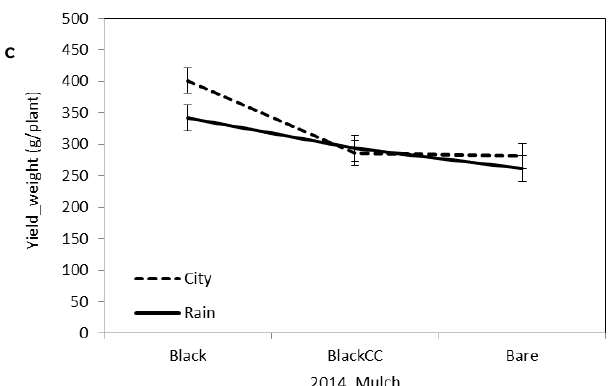
For values within mulch, water followed by the same letter are not significantly different according to Fisher’s LSD ( p = 0.1). EF † and LF † were characterized by nighttime soil temperature in specific EF and LF. Figure 5. Marketable weight of lettuce (mean ± SE) under the effects of different irrigation water (rain and city) over three fall seasons of the years 2011 ( a ), 2013 ( b ), and 2014 ( c ) in high tunnels. Table 3. Interactions of mulch and water on the lettuce yield and soil temperature inside high tunnels during all three falls of years 2011, 2013, and 2014.